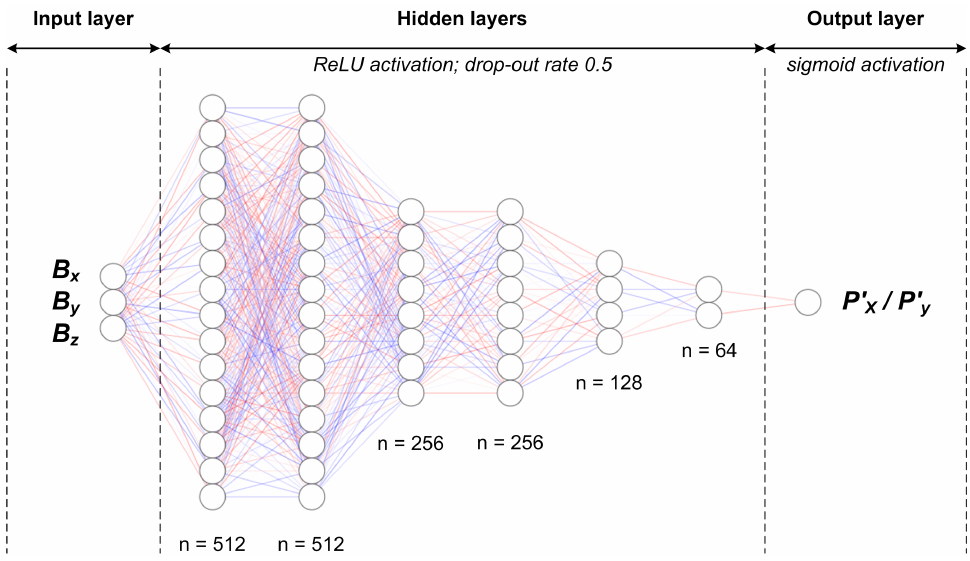
Figure 17. A depiction of the best performing NN topology (each hidden layer node represents 32 neurons in the real architecture). Table 2. Results of NN training for magnet position estimation (estimation error is relative to the canvas/display